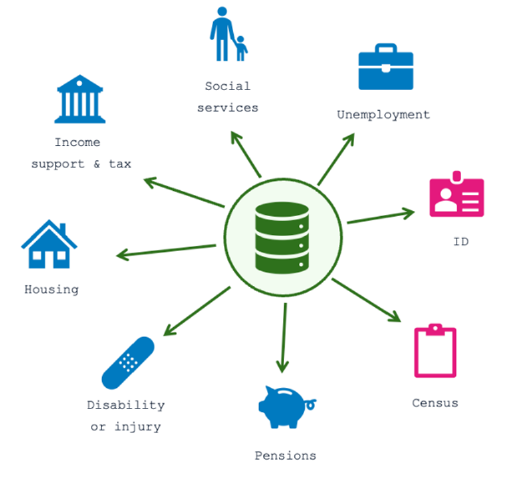
Figure 6: Aggregate welfare (in blue) and citizenship (in pink) datasets stored in the repository